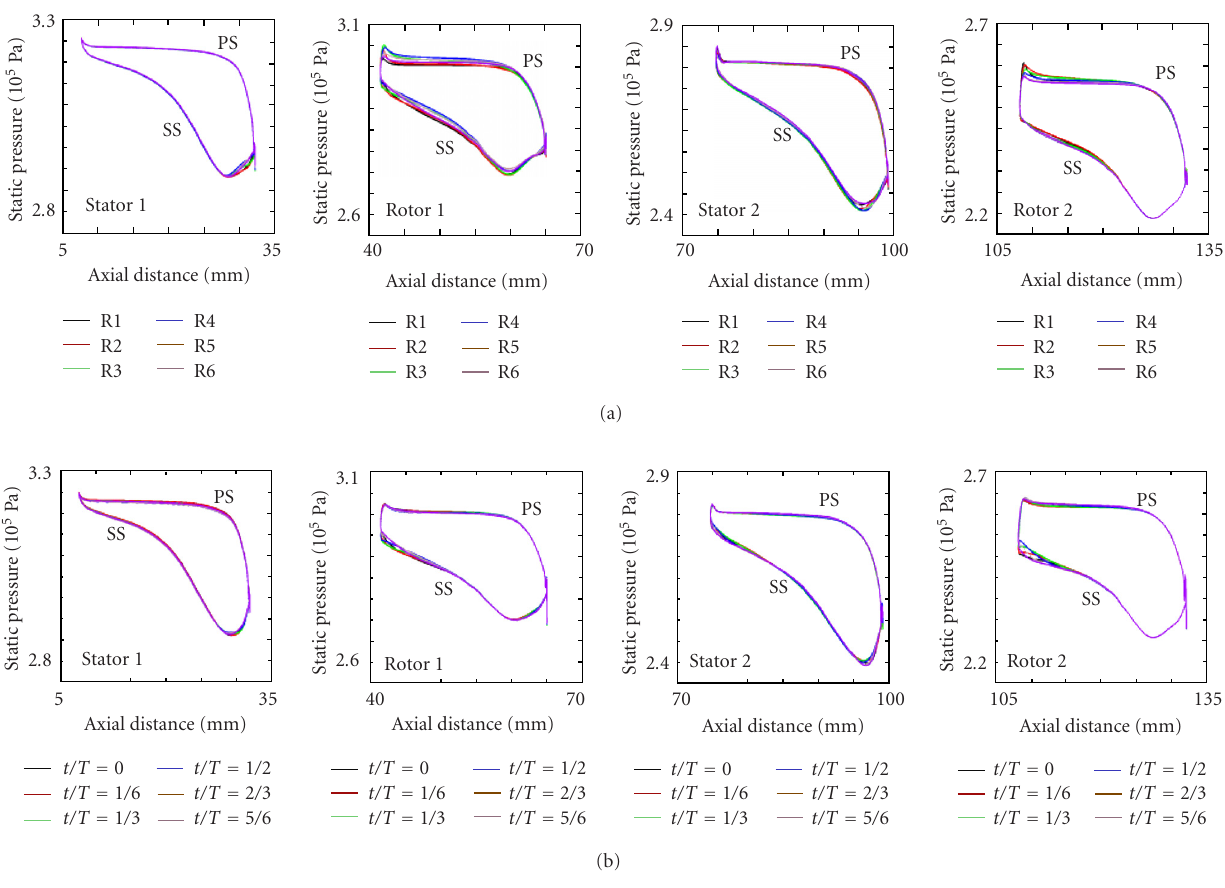
Figure 7: Static pressure distributions at clocking position S3. (a) Frozen rotor approach, steady calculation. (b) Sliding mesh approach, unsteady